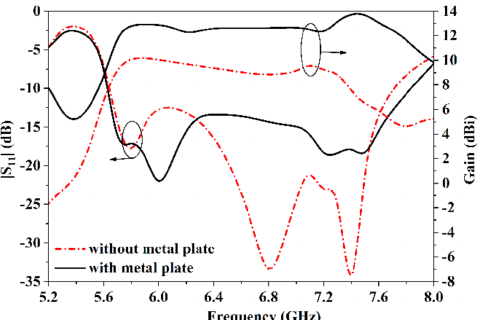
Figure 13. Reflective coefficients and gain of the proposed with and without